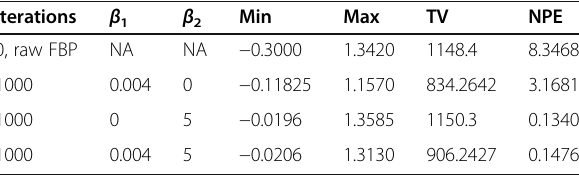
Table 2 Values of maximum, minimum, metal-free region TV, and NPE in reconstructions of bag #2